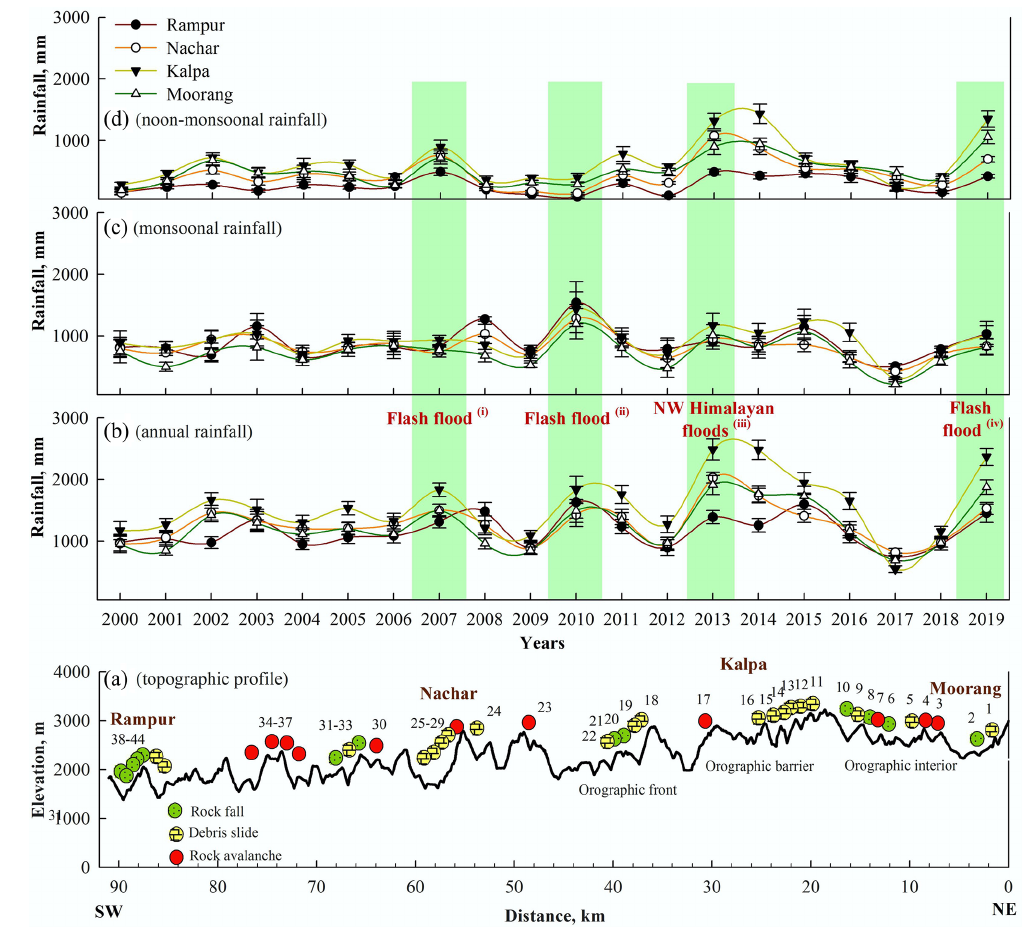
Figure 11. Rainfall distribution: (a) topographic profile, (b) annual rainfall, (c) monsoonal (June–September) rainfall, and (d) non- monsoonal (October–May) rainfall. Green bars represent the years of relatively higher rainfall that resulted in flash floods, landslides, and socio-economic loss in the region. The follow references correspond to the flash flood events listed in (b) . (i): http://hpenvis.nic.in/, last ac- cess: 1 March 2020; Department of Revenue, Govt. of H. P. (ii): http://hpenvis.nic.in/, last access: 1 March 2020. (iii): Kumar et al.